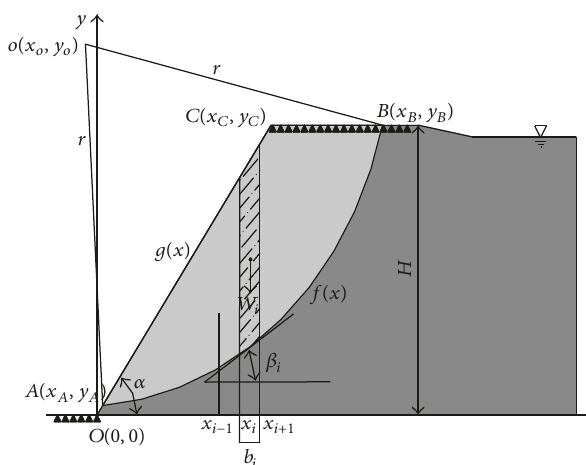
Figure2:Slopesectionofthearcofdestructionwithoutconsidering the impact of phreatic